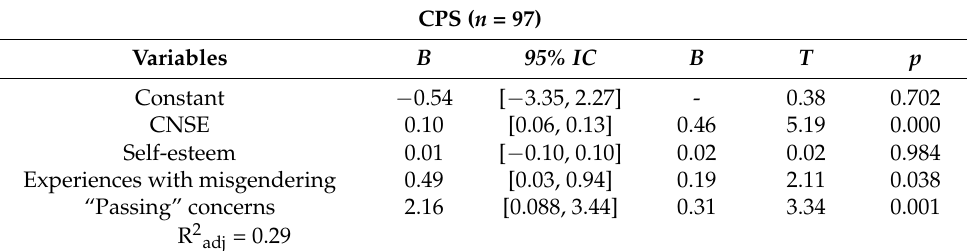
Table 5. Multiple linear regression for CPS in TM and